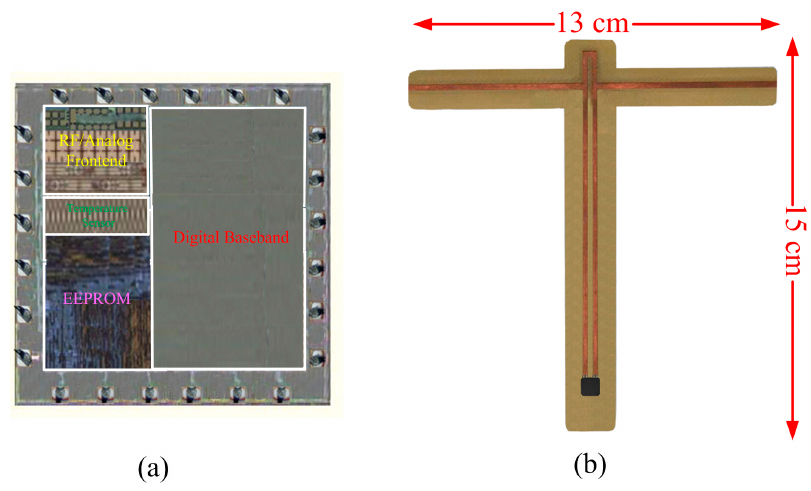
Figure 8. Photo of the proposed RFID sensor tag: ( a ) tag chip; ( b ) RFID sensor tag.